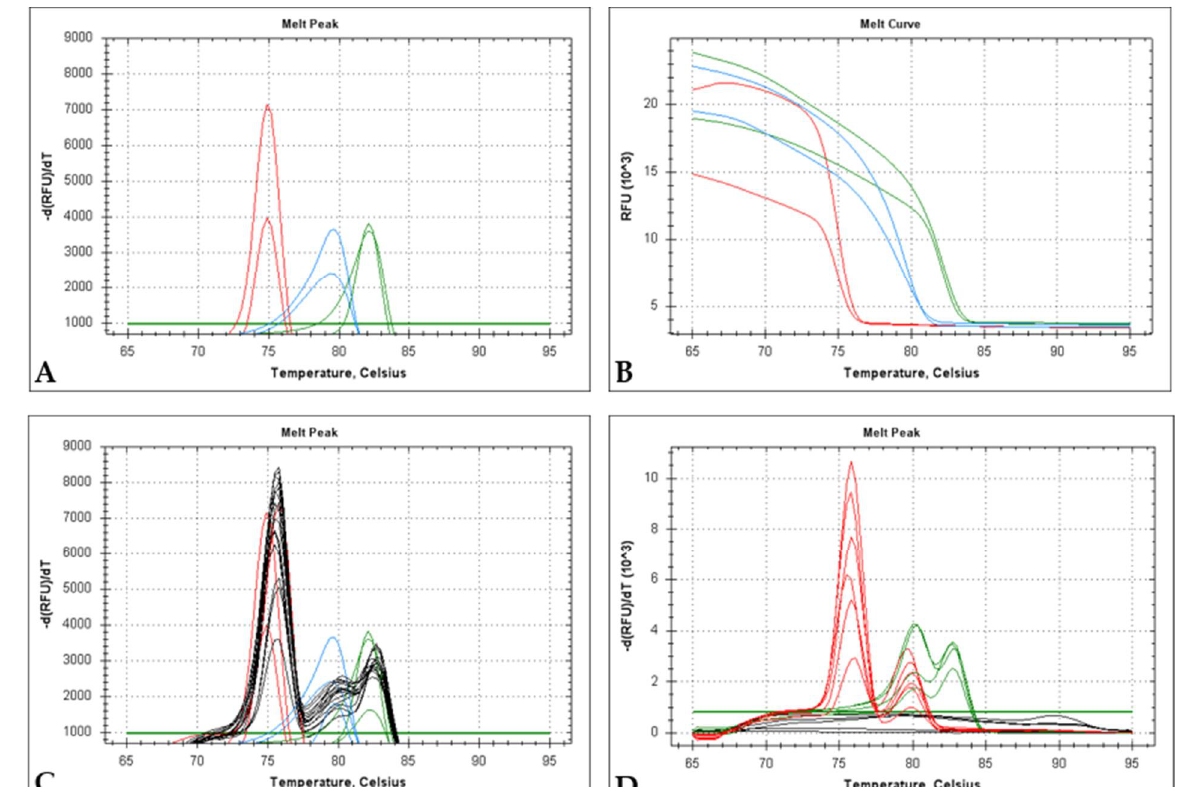
Figure 4. ( A ) Melting peaks of EvaGreen-PCR in singleplex reactions. Red lines, blue lines and green lines correspond to m060L , m000.5L/R and m009L systems, respectively. ( B ) Dissociation curves from ( A ). ( C ) Melting peaks analysis for the three systems described in ( A , B ), superimposed by the respective triplex analysis (three plasmids in the reaction, black lines), with the correspondent three peaks. ( D ) Melting peaks analysis for field samples using the EvaGreen-mPCR, where red lines represent samples positive to ha-MYXV and green lines samples positive for classic MYXV strains.